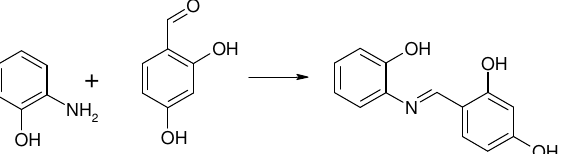
Figure 1 . Synthesis of 4-[(2-hydroxyphenylimino)methyl]benzene-1,3-diol (HIBD). Elemental